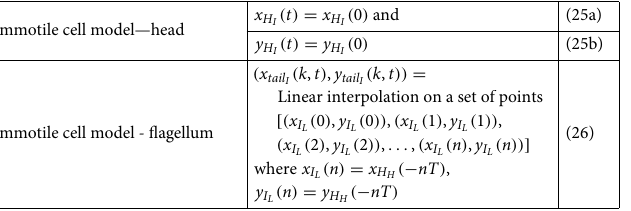
Table 4. Simulation of an immotile cell. ( x H a curve along the center of the flagellum of immotile cell.